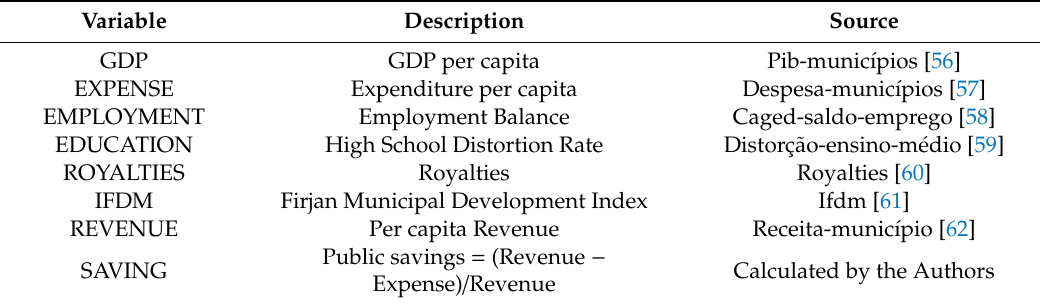
Table 6. Description of variables and data